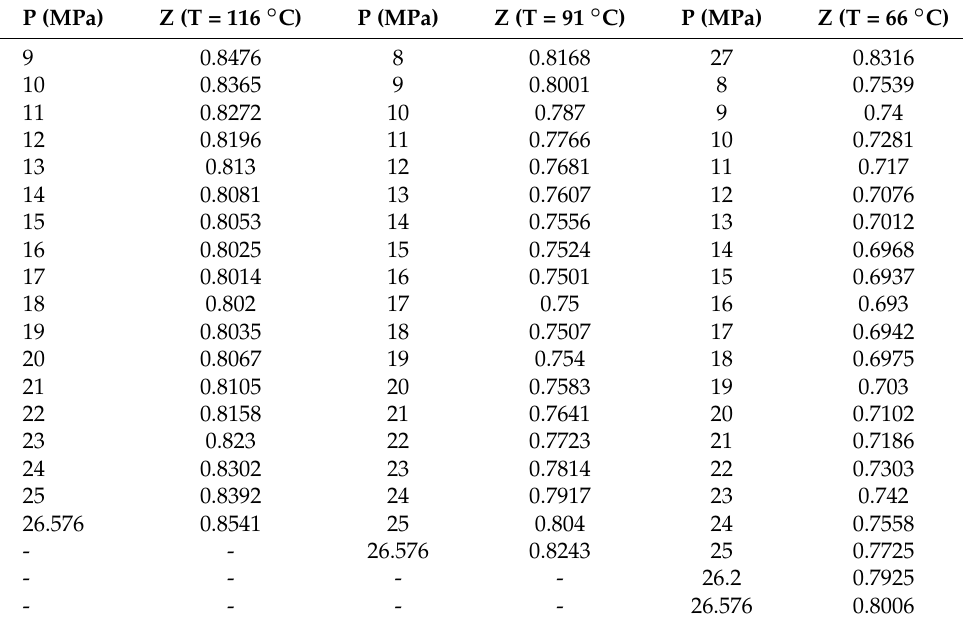
Table A4. Measured compressibility factors of sample 3 in the H2